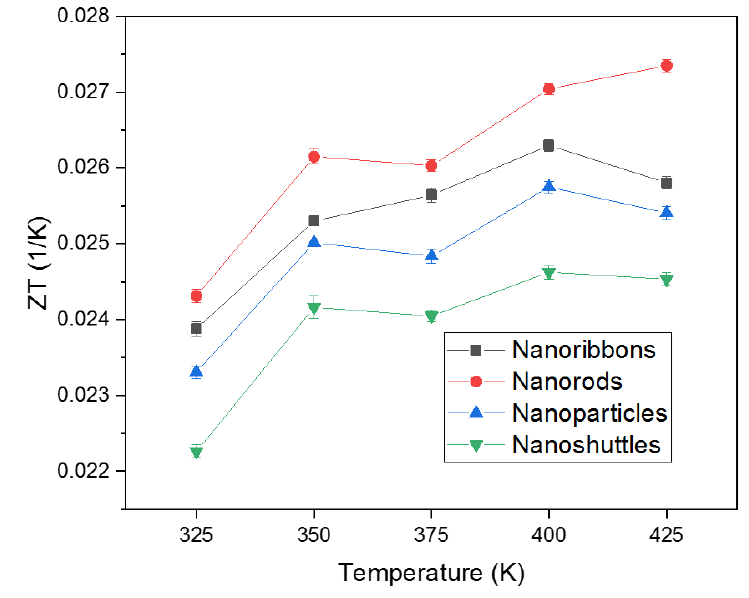
Figure 8. Figure of merit of ZnO nanostructures.